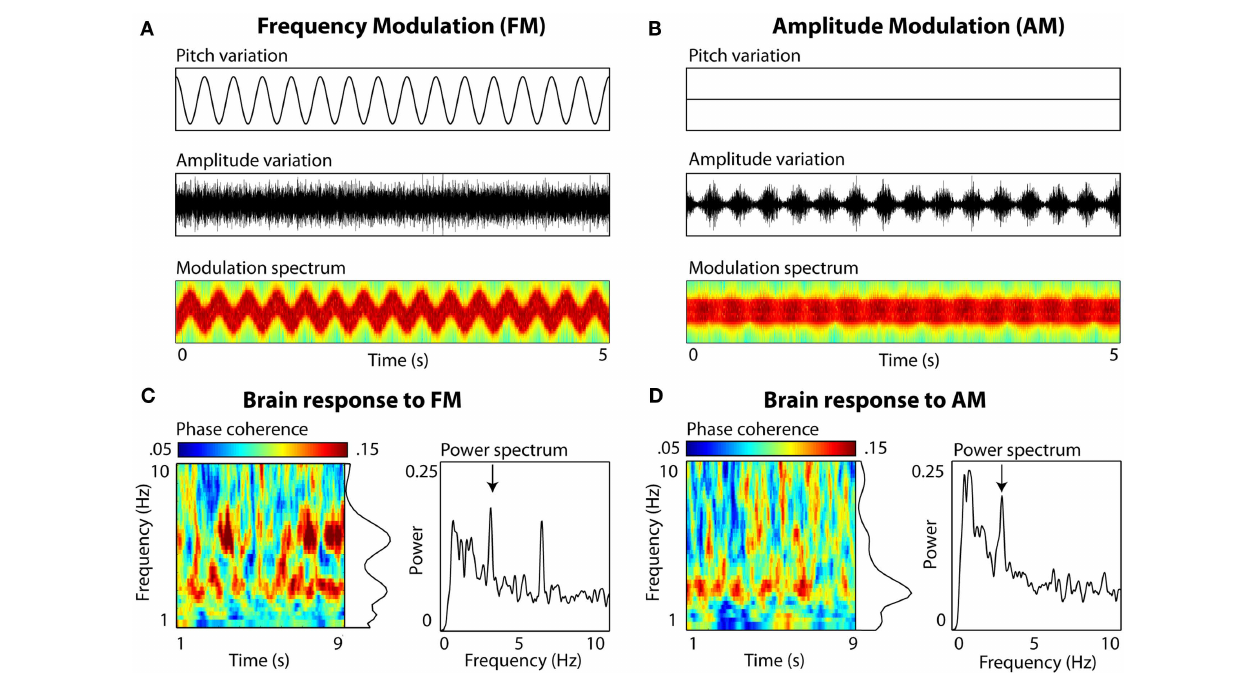
Figure 1 | Auditory entrainment of slow neural oscillations independent of envelope fluctuations. Participants ( N = 10) passively listened to 10-s complex tone stimuli (composed of 30 components sampled uniformly from a 500 Hz range), sinusoidally frequency-modulated (FM), or amplitude-modulated (AM) at a rate of 3 Hz. Electroencephalography (EEG) was recorded (data from electrode Cz shown). (A) FM stimuli. Left panels show variations in frequency (Pitch variation) and amplitude (Amplitude variation) over 5 s of stimulation. Modulation spectrum shows frequency ( y axis; 200–1800 Hz, scaled linearly) and amplitude variations (color scaling) as a function of time ( x axis). Note that there are no systematic variations in amplitude envelope to which brain rhythms